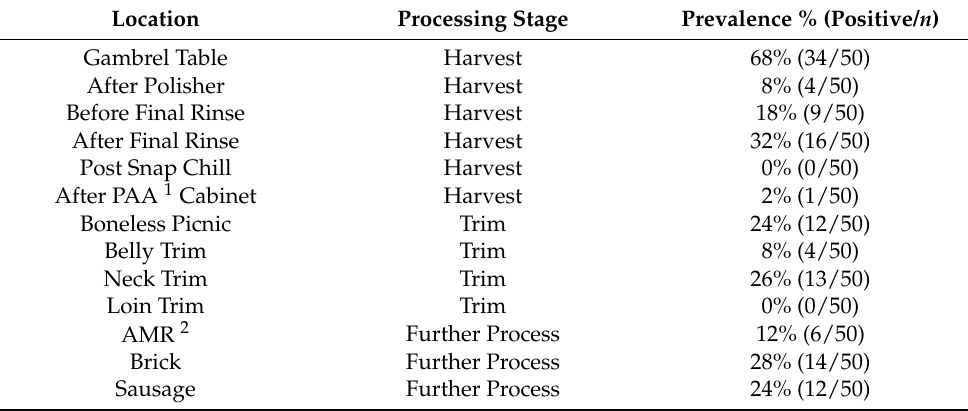
Table 6. Salmonella prevalence in % and Salmonella -positive sample ratio at each sampling location throughout the pork processing